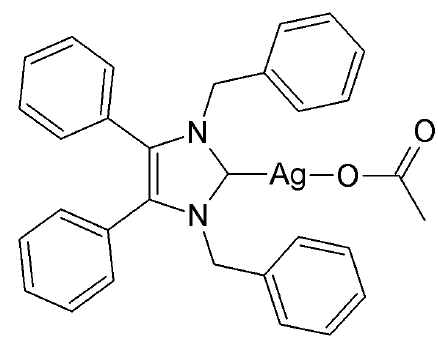
Figure 1. Molecular structure of